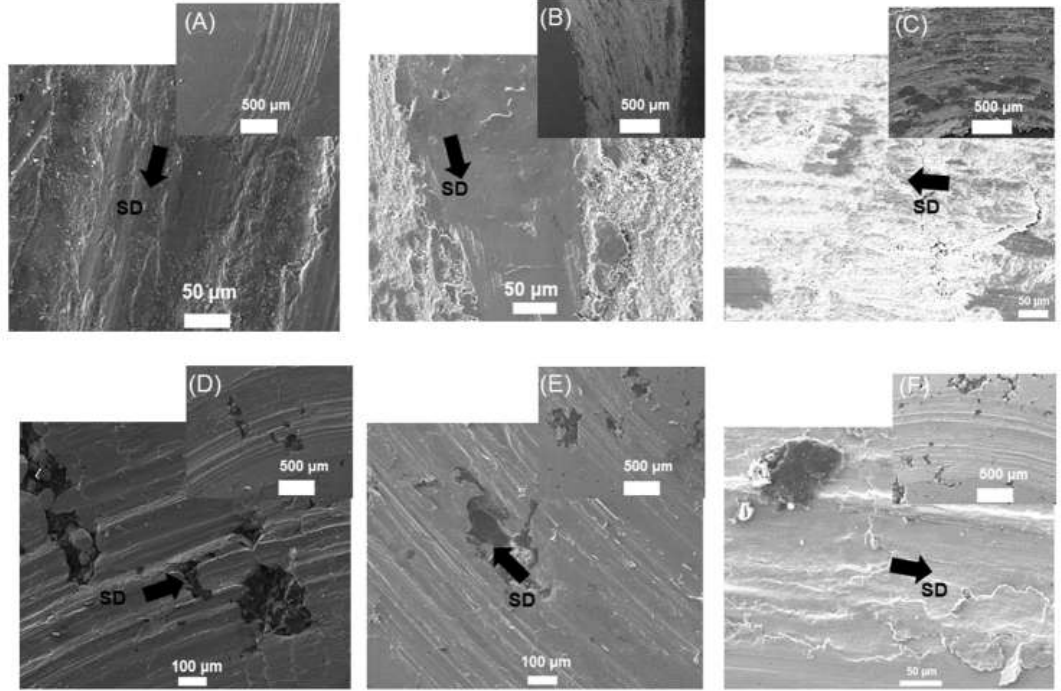
Figure 8. SEM morphology of the worn surface of the sintered discs that sliding against different counterbodies ( A ) Cu/Al 2 O 3 ; ( B ) Cu/SiC; ( C ) Cu/SuJ2; ( D ) Cu-MgPG/Al 2 O 3 ; ( E ) Cu-MgPG/SiC; ( F ) Cu-MgPG/SuJ2.